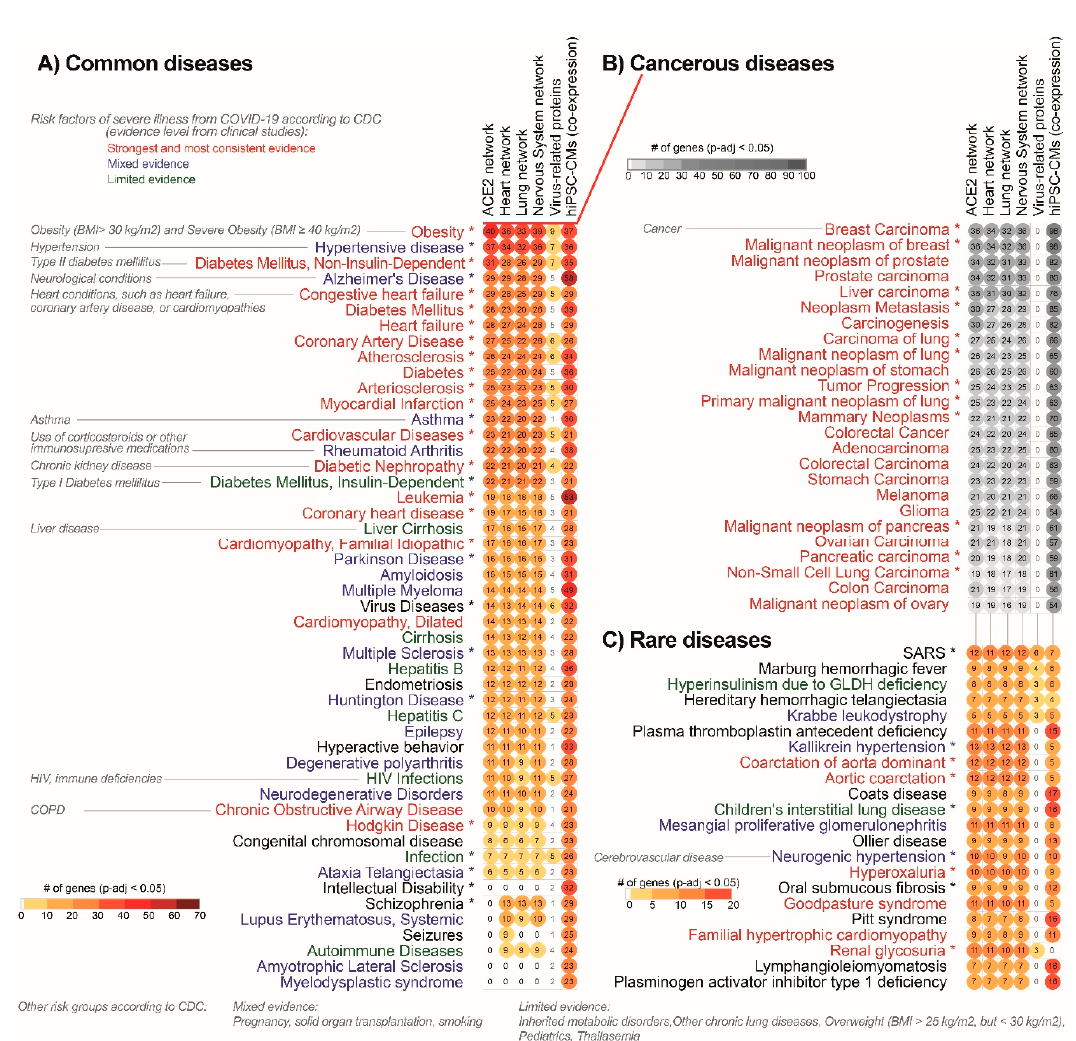
Figure 6. Top potential COVID-19 risk groups are significantly associated with ACE2 interaction networks. Risk groups are characterized as ( A ) common, ( B ) cancerous and ( C ) rare diseases. This list is based on enrichment analysis of a database of gene-disease associations (DisGeNET), analyzed through the EnrichR database. We performed disease enrichment analysis in the complete ACE2 network (leftmost column of symbols), and subsets of this network expressed in the heart, lung, and nervous system; we also performed this same analysis for 11 virus-infection related proteins (rightmost column) and ACE2-co-expression network in stem cell-derived cardiomyocytes (hiPSC-CMs) after 72 h of infection. Diseases marked with asterisks include the ACE2 gene. For heart, lung and nervous system tissue, we used the cutoff of expression confidence > 2, obtained from the Tissue2.0 database. All circles presented on the graph are associated with significantly enriched disease terms (False Discovery Rate corrected p -value < 0.05). Top cancer-related diseases are shown on panel B and were subset from the DisGeNET diseases list by using cancer-related keywords. Notice that top diseases are already known as major risk groups in COVID-19. Label colors are associated with evidence of underlying medical conditions that increase the risk of severe illness from COVID-19 according to the Centers for Disease Control and Prevention (CDC) [https: // www.cdc.gov / coronavirus / 2019-ncov / need- extra-precautions / evidence-table.html updated on 2 November 2020]. “Strongest and most consistent evidence” was defined as consistent evidence from multiple small studies or a strong association from a large study; “Mixed evidence” was defined as multiple studies that reached different conclusions about risk associated with a condition; and “Limited evidence” was defined as consistent evidence from a small number of studies. Unassigned terms are marked with black color.